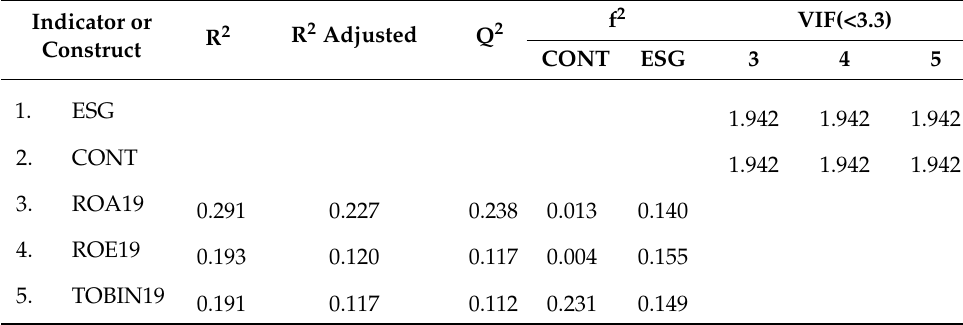
of the tests of the proposed hypotheses are displayed.